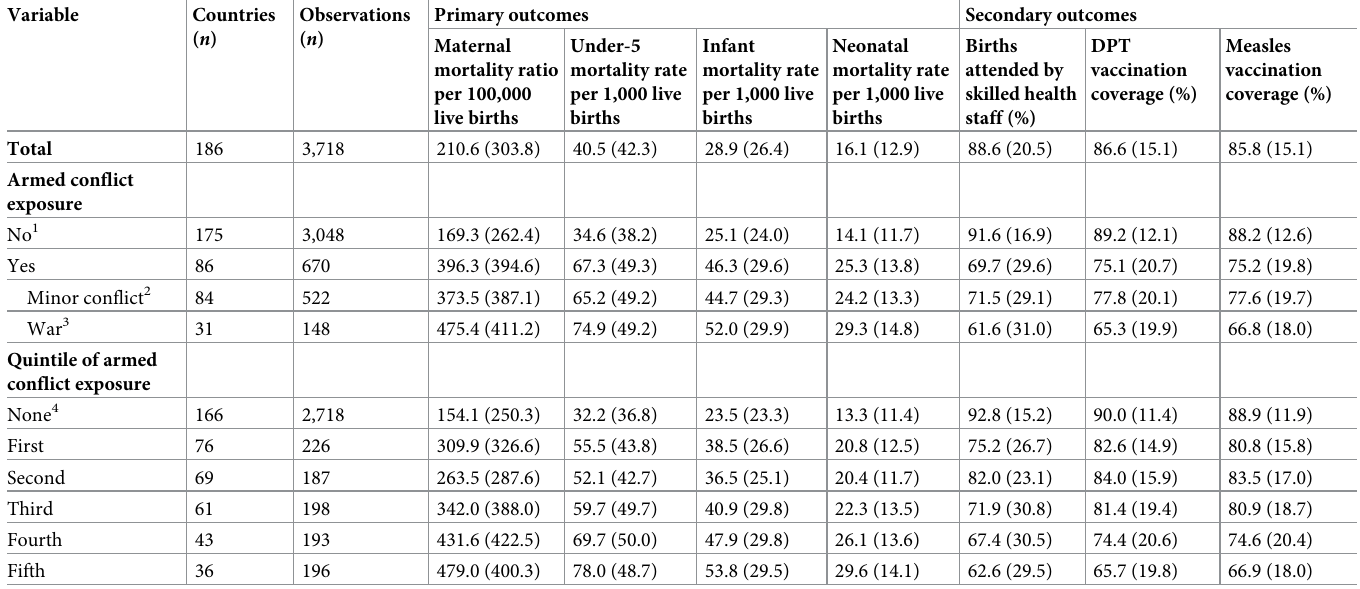
Table 1. Description of data used in the